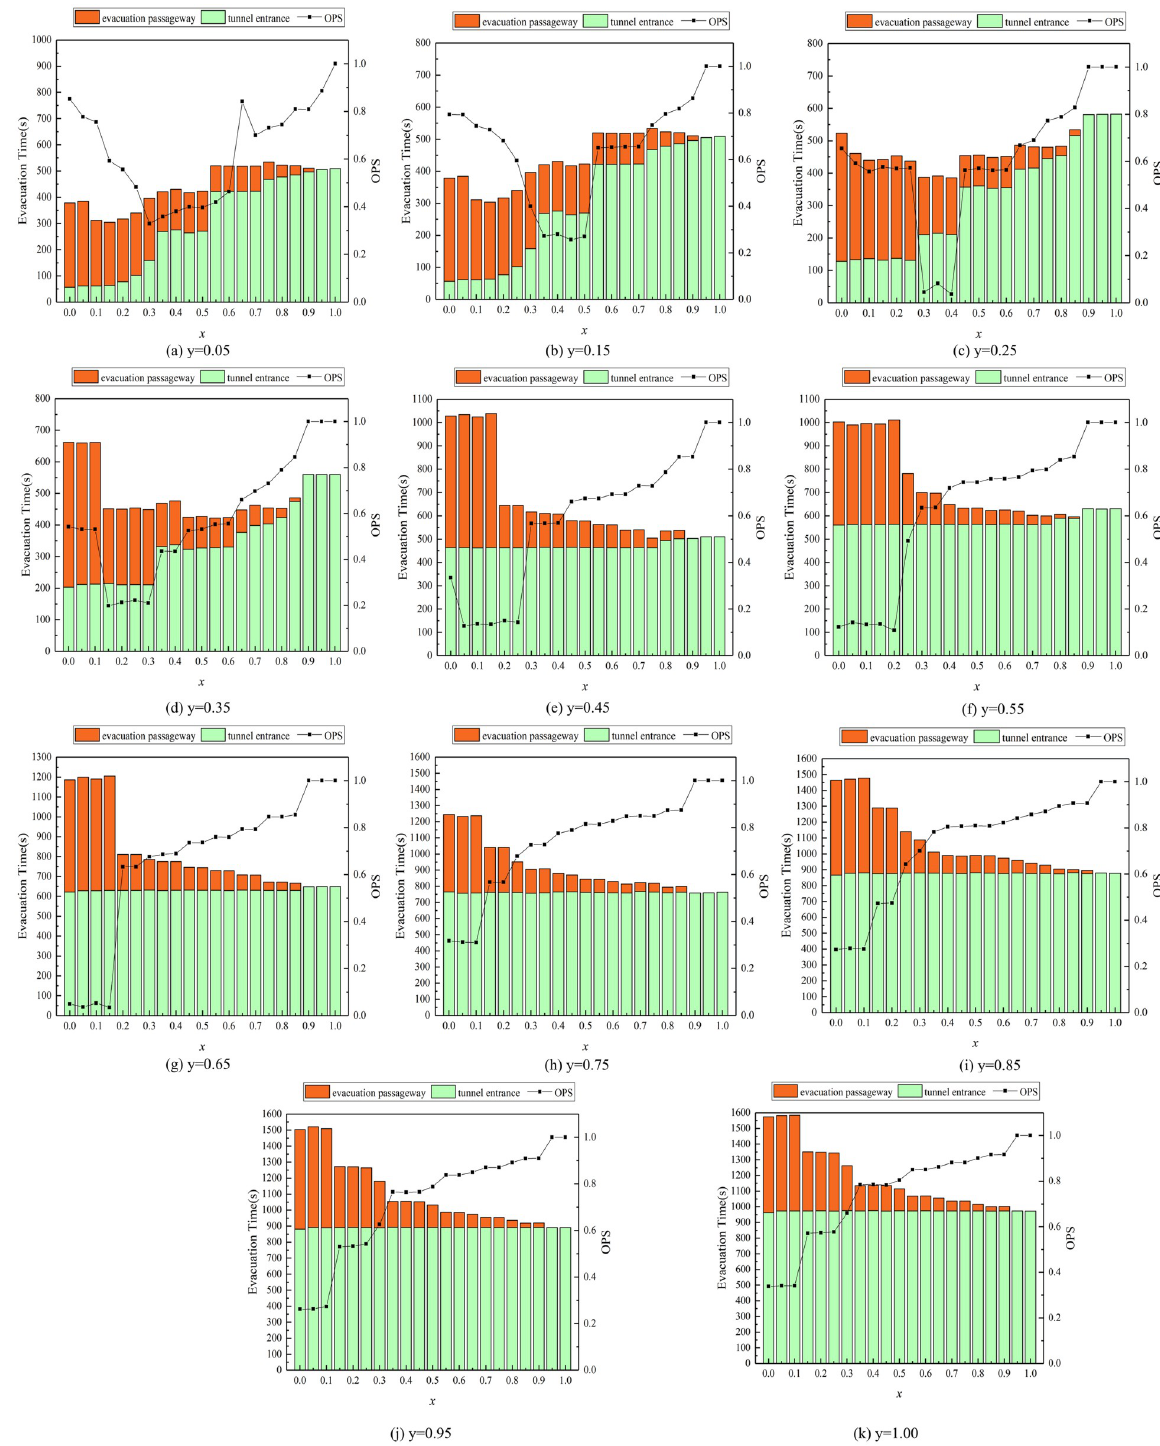
Fig 5. Evacuation time and OPS of tunnel entrance and evacuation passageway.